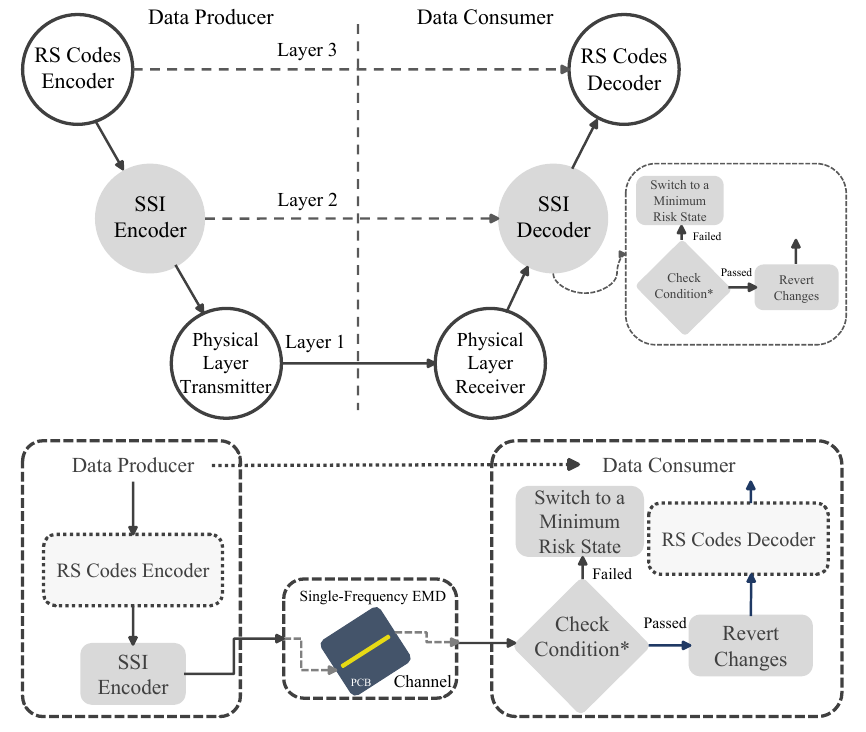
Figure 8. Conceptual overview of the proposed multi-layer communication